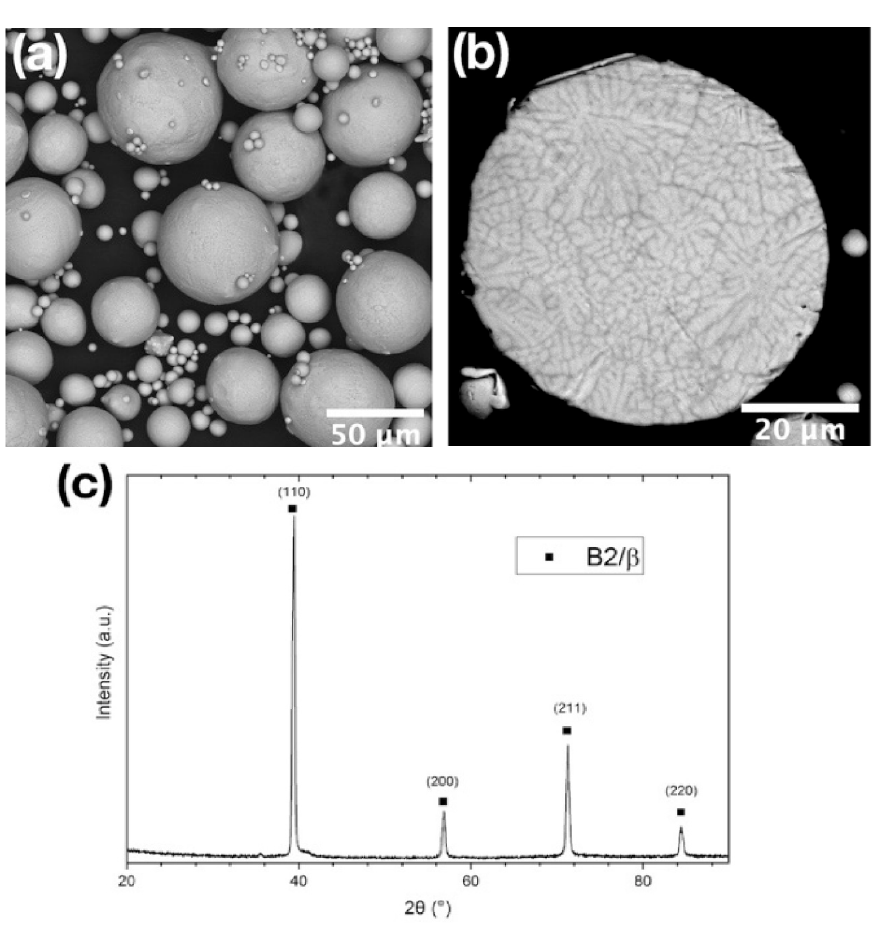
Figure 5. SEM images of the Ti 2 AlNb-based powder showing ( a ) particles’ surface morphology; ( b ) their cross-section; ( c ) XRD pattern of the powder. Reproduced with permission from Elsevier [72].